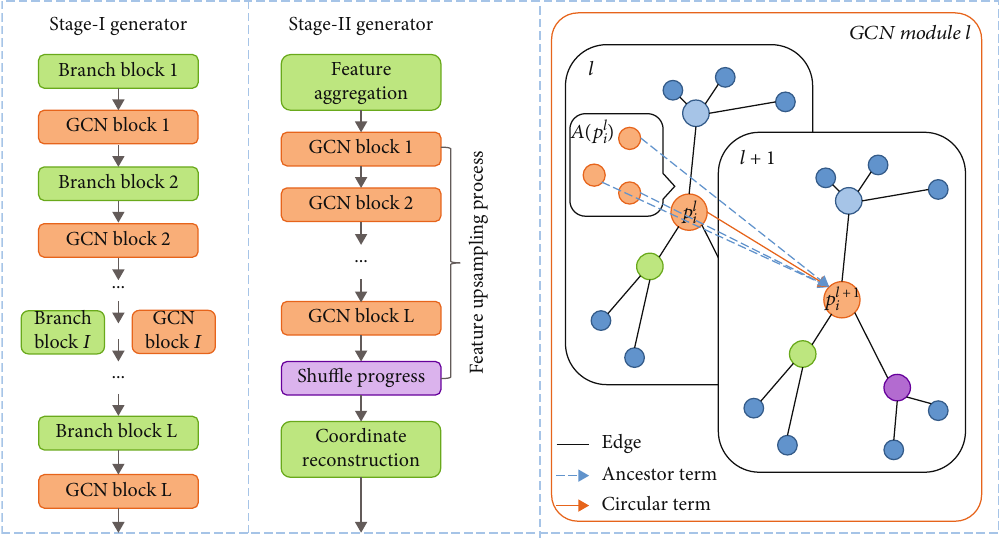
Figure 4: The structure of the stage I generator and stage II